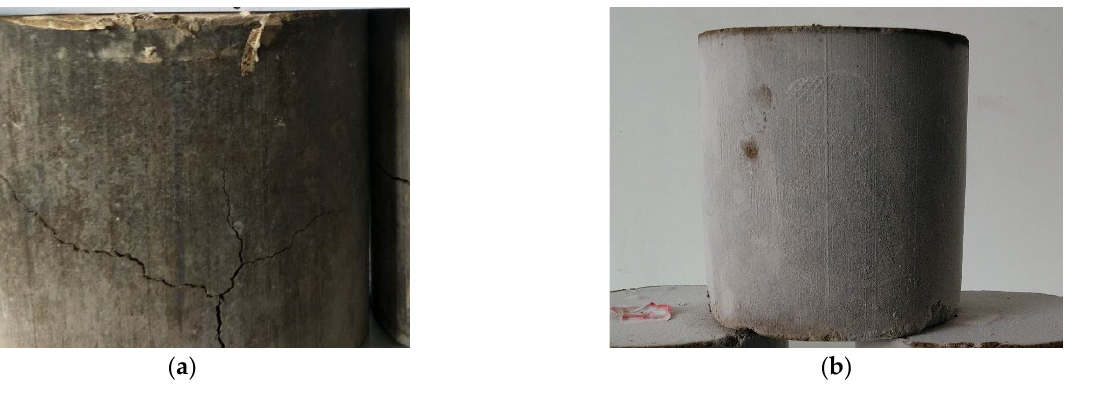
Figure 10. Soil sample state after low temperature freeze-thaw. ( a ) Cement stabilized; ( b ) flexible curing agent stabilized.